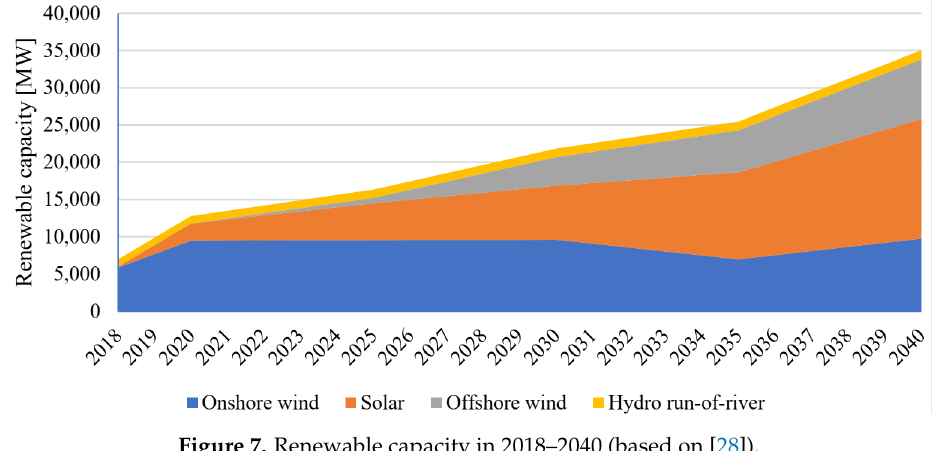
Figure 7. Renewable capacity in 2018–2040 (based on